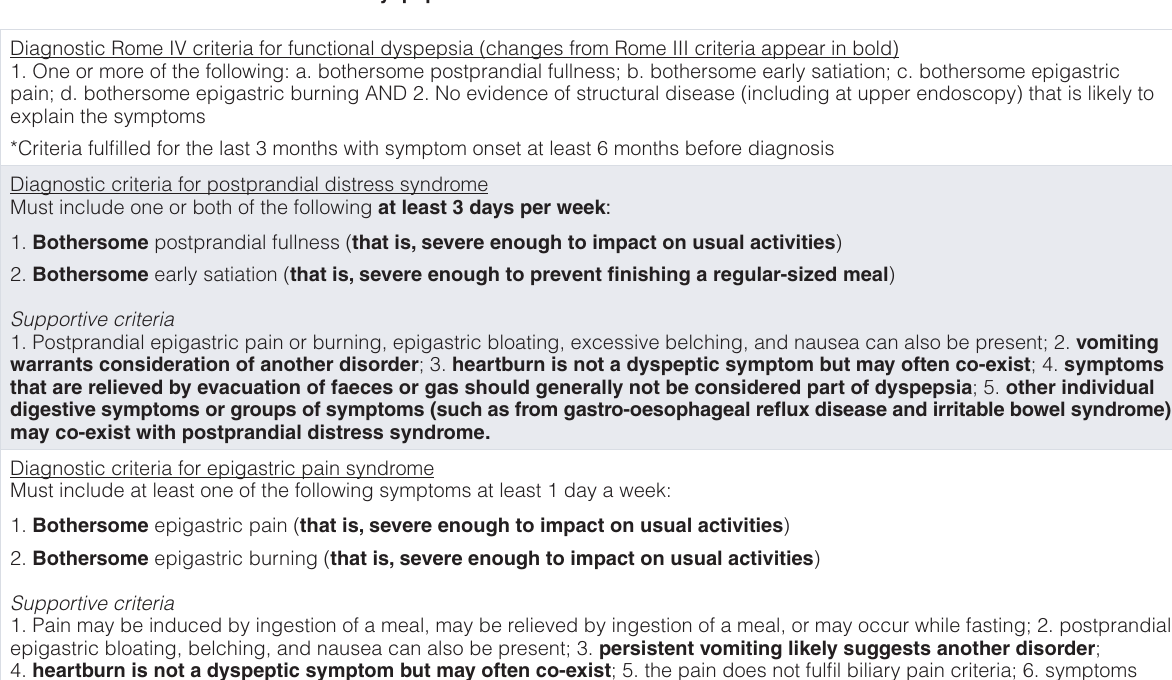
Table 1. Rome IV criteria for functional